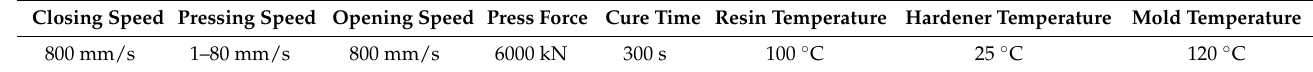
Table 1. Detailed processing parameters applied for HP-RTM process.